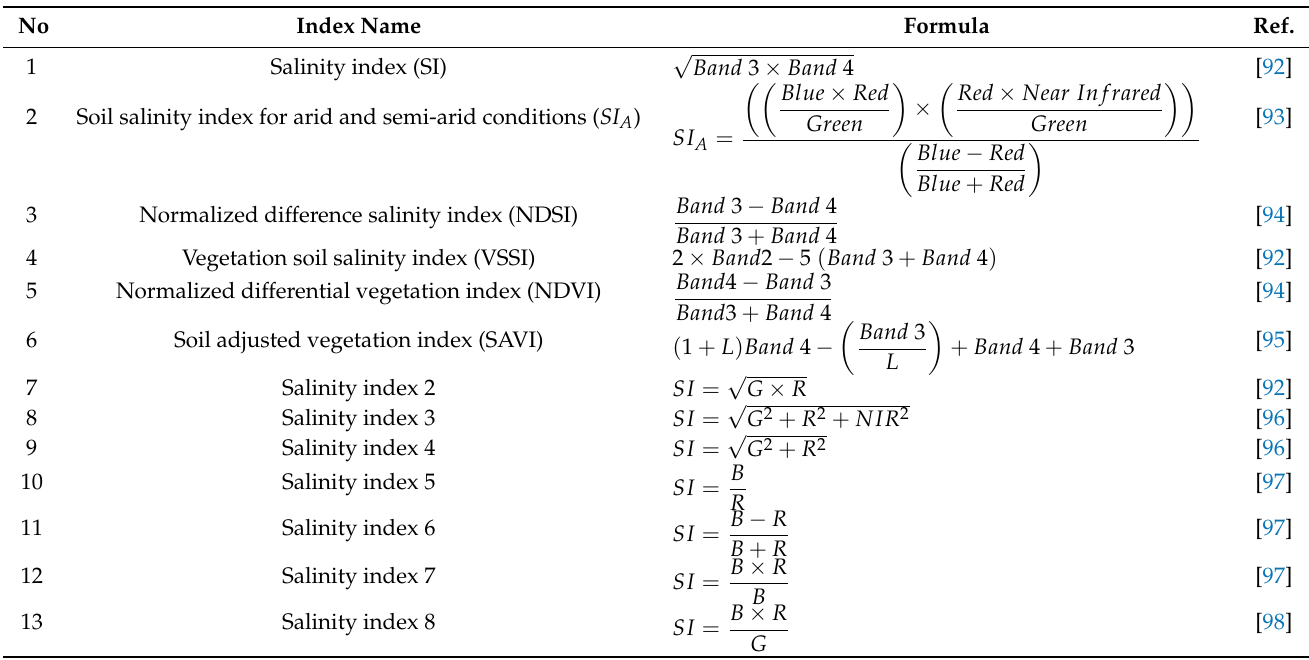
Table 2. Soil salinity indices based on different band ratios of